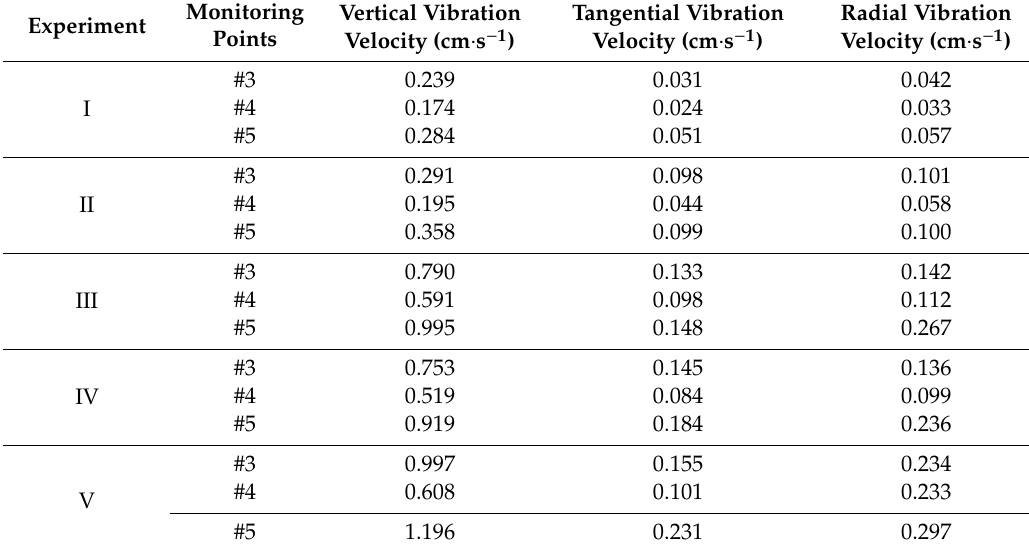
Table 2. The vibration velocity of each component of the monitoring point in the